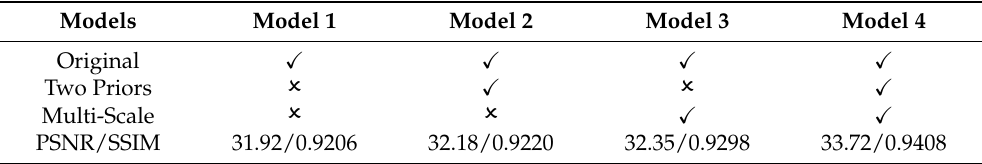
Table 1. PSNR (dB)/SSIM Results of Images after Rain Removal by Different Models.